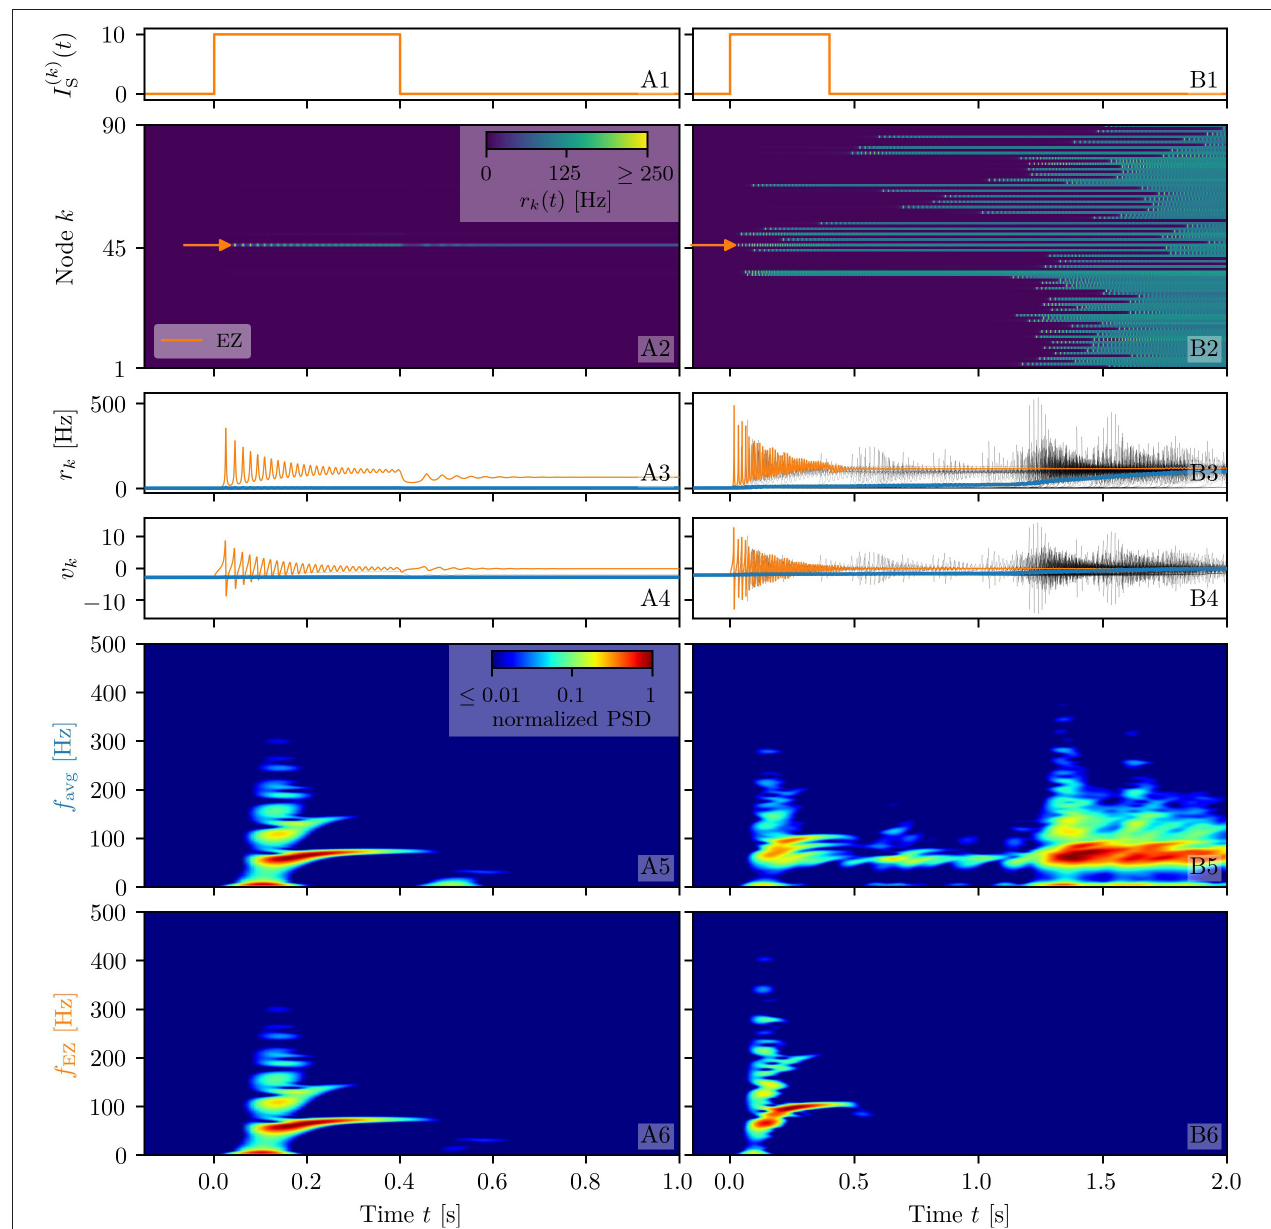
FIGURE 2 | Spectrograms of mean membrane potentials for healthy subject H1. (A1, B1) Stimulation current I ( k ) S , (A3, B3) population firing rates r k , and (A4, B4) mean membrane potentials v k for the EZ (orange) and other populations (black). The blue curves show the network average firing rate and membrane potential. Non-stimulated node dynamics are plotted as transparent gray curves: some of the nodes adapt their voltage to the stimulation of the EZ and change during stimulation. (A2, B2) Space-time plots of the population firing rates r k , color-coding the value of the firing rate of each node, as a function of time. (A5, B5) Spectrogram of the network average membrane potential and (A6, B6) of the v k of the EZ. Column A shows an asymptomatic seizure-like event for η ( k ) η column B shows a generalized seizure-like event for 6.3. In both cases, the EZ node 46 is stimulated. Parameter values: N pop ¯ = ¯ = − J kk k l . 20, σ 1, J kl 5 ˜ J kl , = = = ∀ 6=